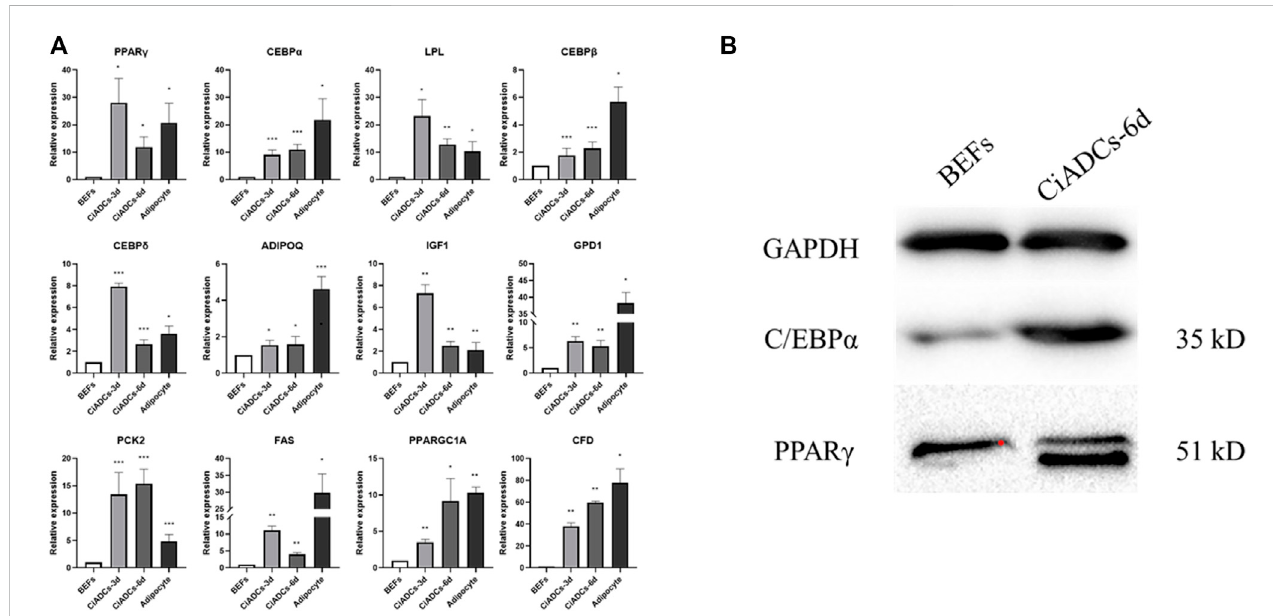
Characterization of adipogenesis induced by RVB in BEFs. (A) qRT-PCR analysis the expression of adipogenic marker genes of PPAR γ , C/EBP α , LPL, C/ EBP β , C/EBP δ , ADIPOQ, IGF1, GPD1, PCK2, FAS, PPARGC1A, and CFD among CiADCs-3d, CiADCs-6d and natural adipocytes. Values (mean ± SD) are normalized with respect to the β -actin mRNA level in each sample. Signi fi cant differences * p < 0.05; ** p < 0.01; *** p < 0.001. (B) . Western blot analysis of PPAR γ and C/EBP α protein levels in induced adipocyte-like cells